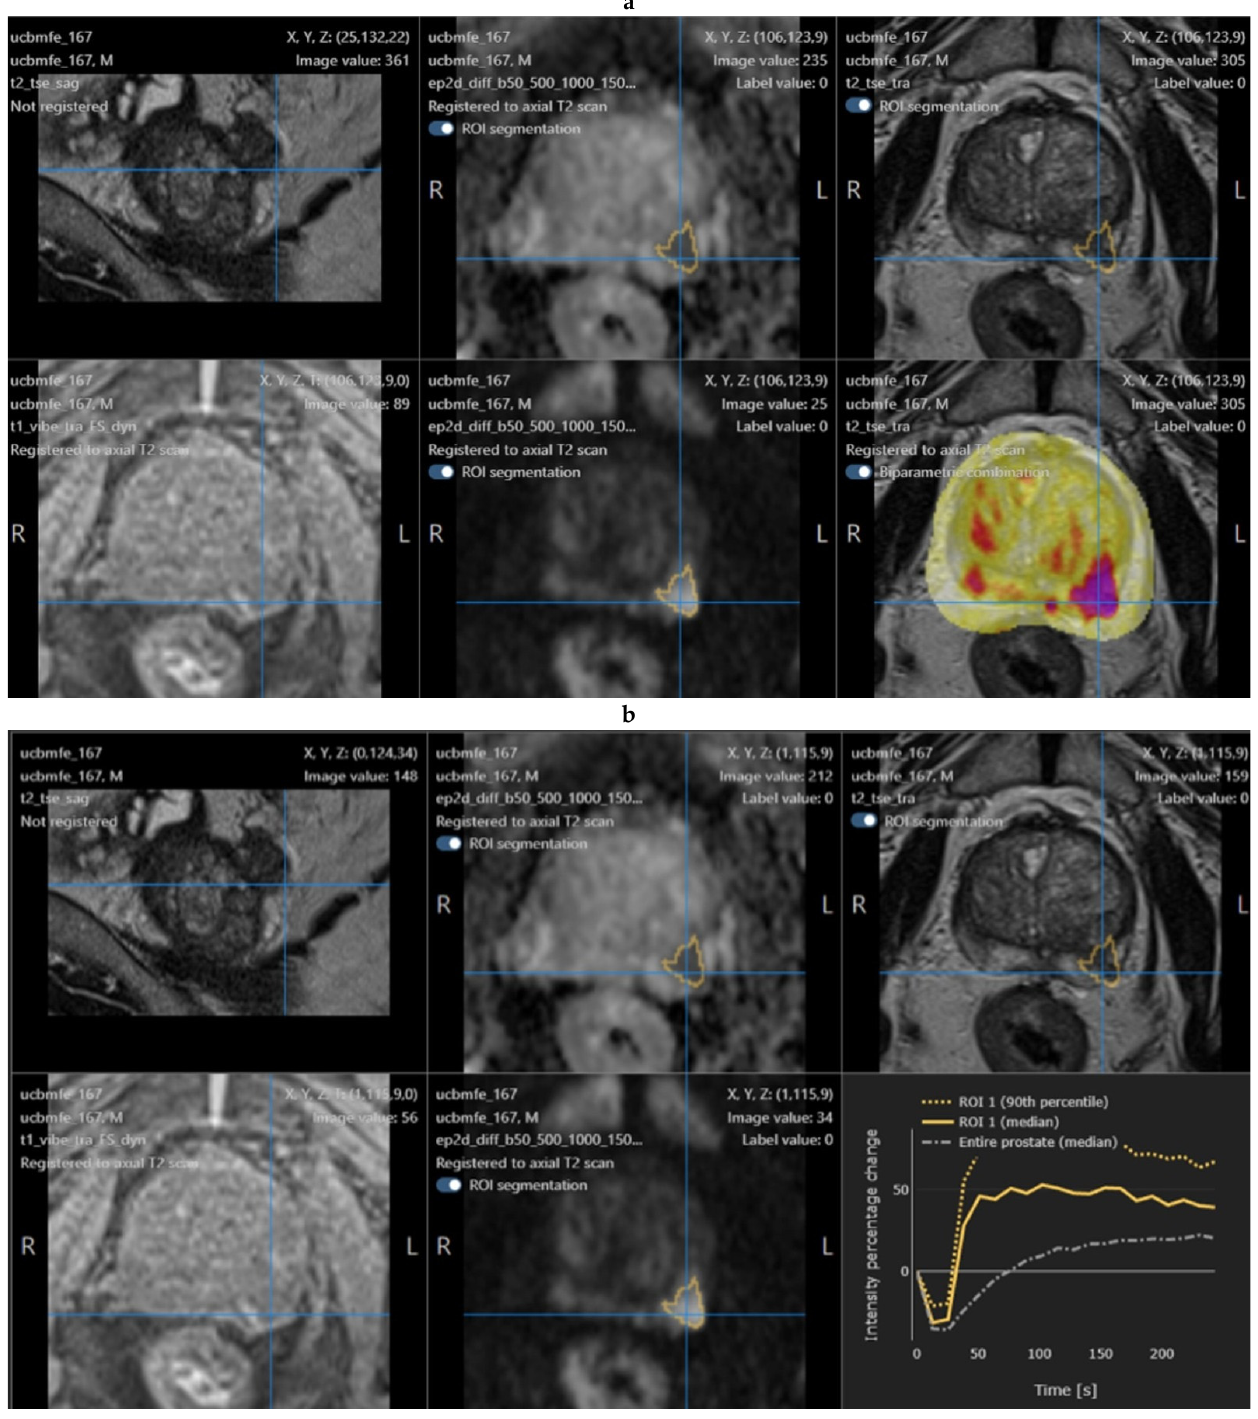
Figure 1. Example of a positive mpMRI prostate nodule, showing the original software interface with the segmentation of the lesion ( a ) and post-contrast enhancement curve ( b ).